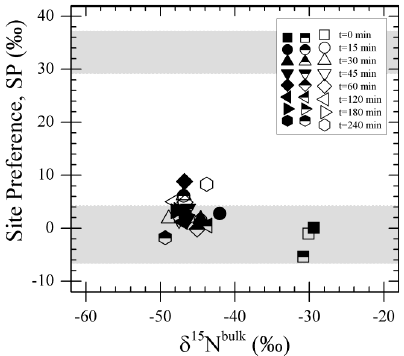
Fig. 4. Relationships between SP and δ 15 N bulk values of dis- solved N 2 O at DO settings of 0.2 mg L –1 (closed symbols), 0.5 mg L –1 (half closed symbols) and 0.8 mg L –1 (open sym- bols). Expected ranges of δ 15 N bulk values for the N 2 O pro- duced by NH 2 OH oxidation and NO 2- reduction estimated using Eqn. (7) and those of SP are shown by gray boxes at the top and bottom